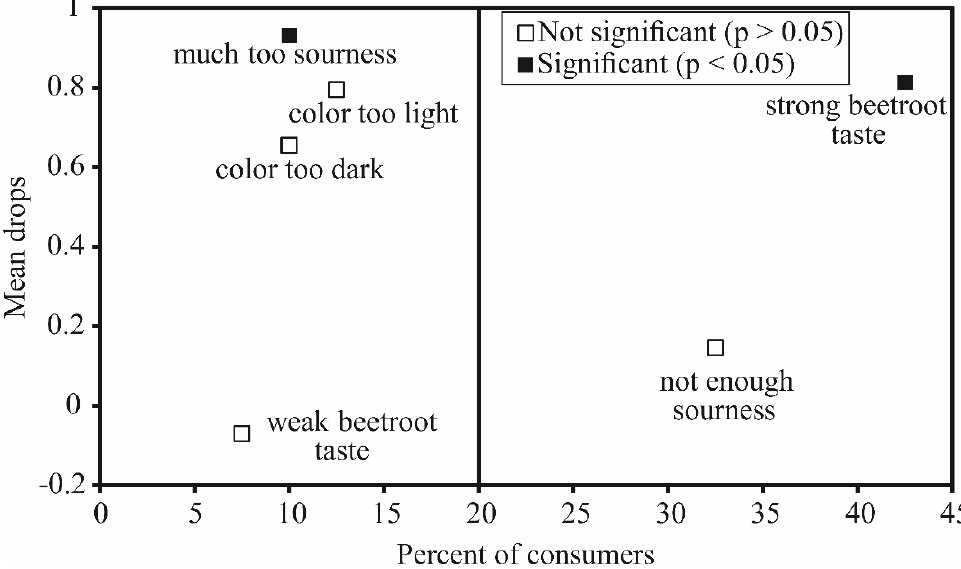
Figure 5. Mean drop analysis of the BPF yogurt sample ( N = 40).